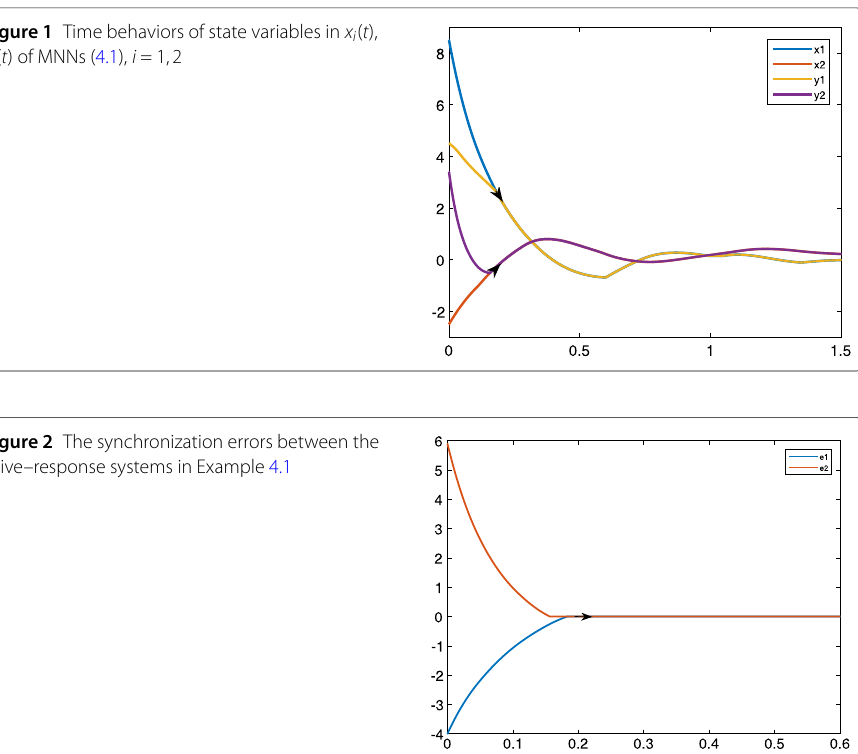
Figure 2 The synchronization errors between the drive–response systems in Example